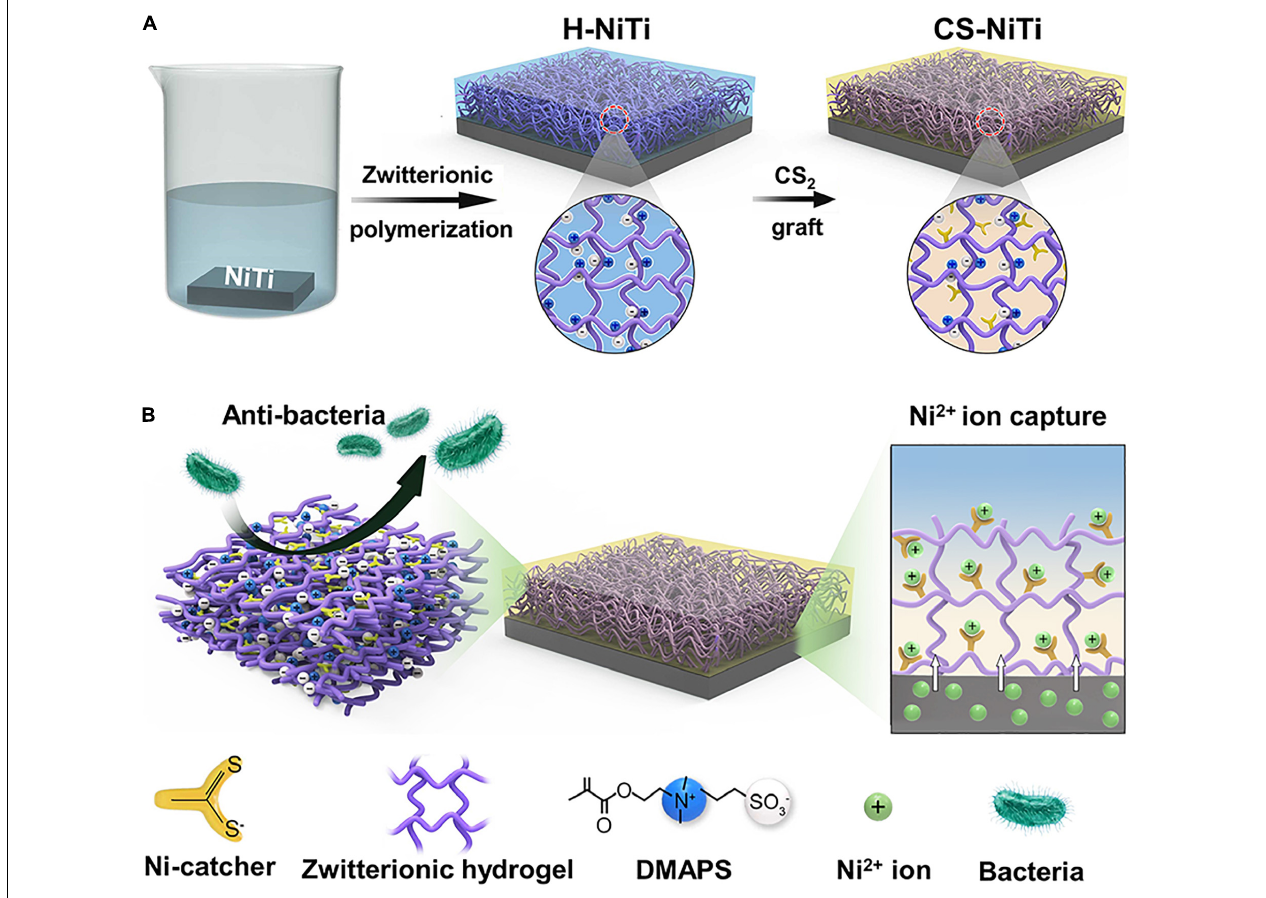
FIGURE 1 | Design principle of CS-NiTi for long-term Ni 2 + ion capture. (A) Schematic of the fabrication process of CS-NiTi. (B) The as-prepared CS-NiTi shows dual functions of anti-bacteria and Ni 2 + ion